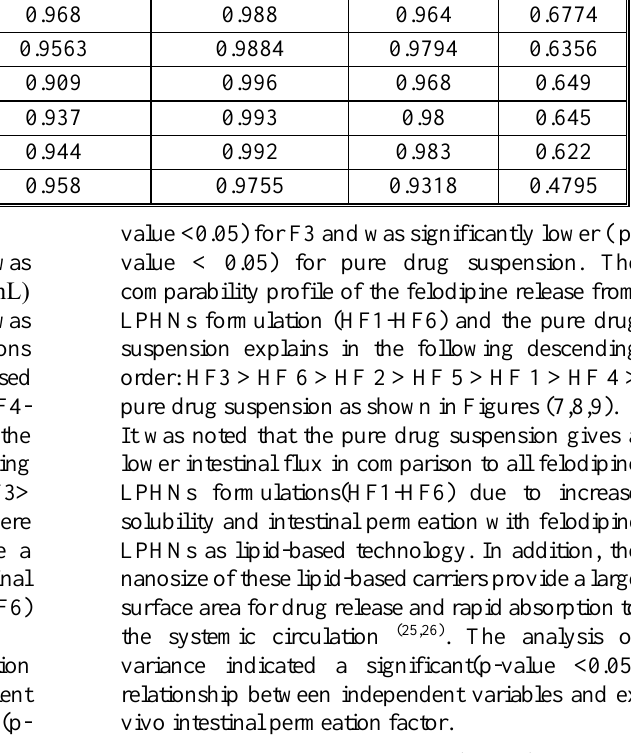
Table 5. The slope and permeation coefficient for felodipine from LPHNs formulations (F1-F9) and pure drug suspension through non-everted sheep